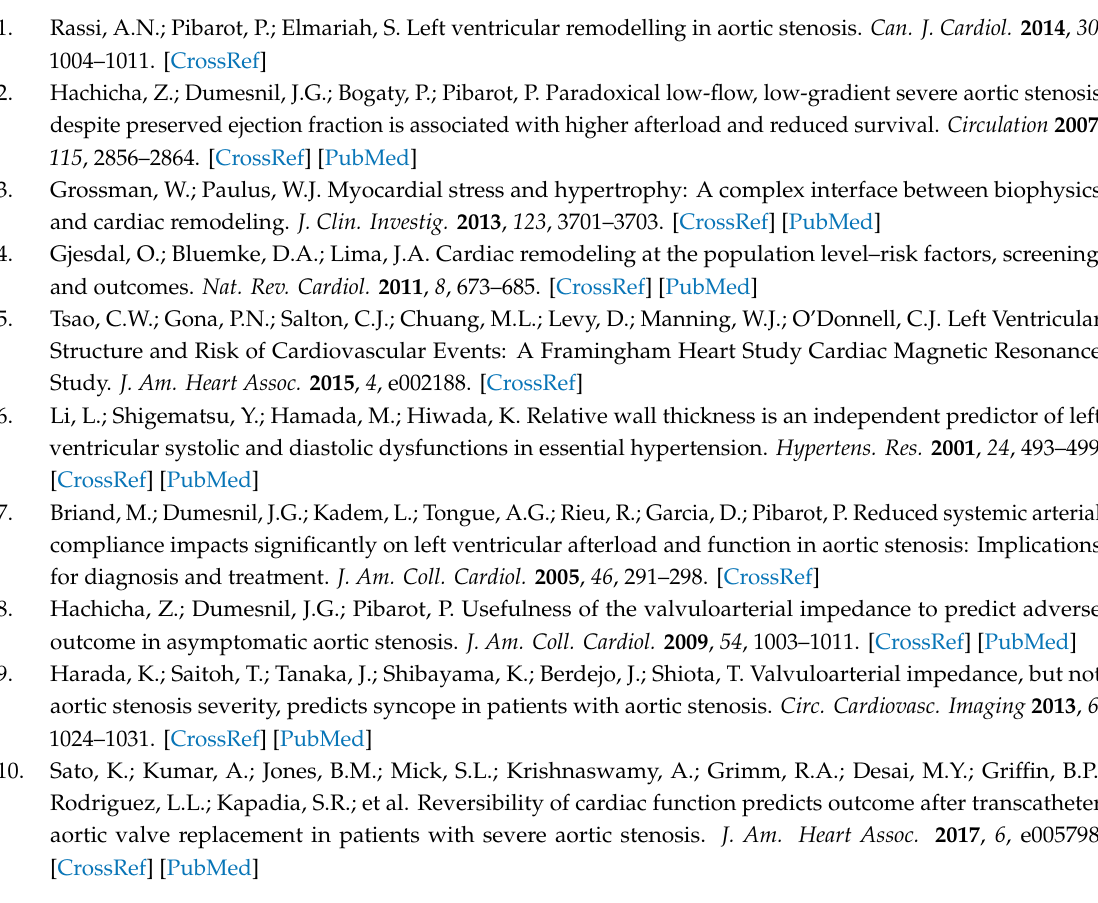
Table S1: Valve system of transthoracic aortic valve